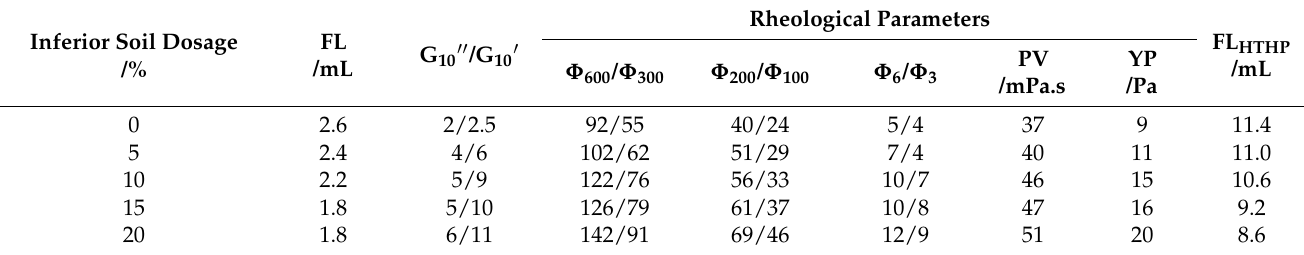
Table 6. Evaluation of anti-poor soil pollution